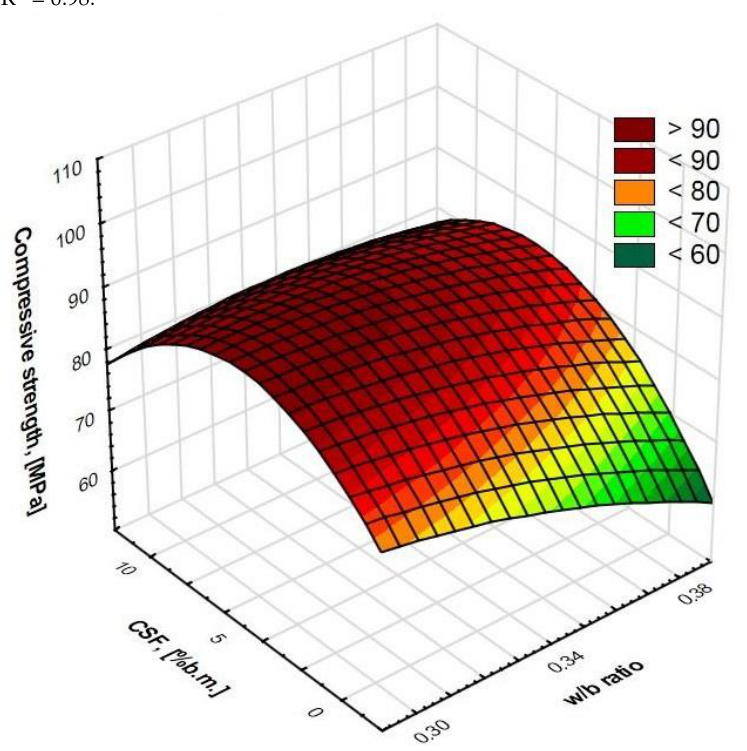
Figure 7. Surface chart. Relationship between w/b ratio and CSF on compressive strength. R 2 = 0.99.